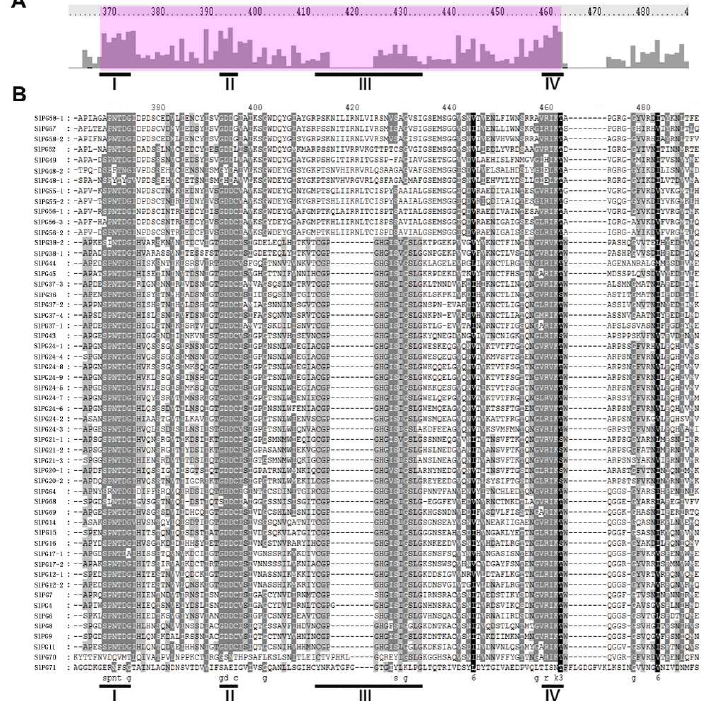
Figure 1. Multiple sequence alignment analysis of the peptides of polygalacturonases (PGs) containing the four typical conserved domains in S. lycopersicum . ( A ) Alignment of the tomato PG peptides containing the four typical conserved domains. The height of the bars indicates the number of identical residues per position. The underlines illustrate the four typical conserved domains of PGs; ( B ) Multiple alignments of the peptides of tomato PGs containing four conserved domains. Black and light gray shading, respectively, indicate identical and conserved amino acid residues. Conserved domains are also underlined and correspond to part